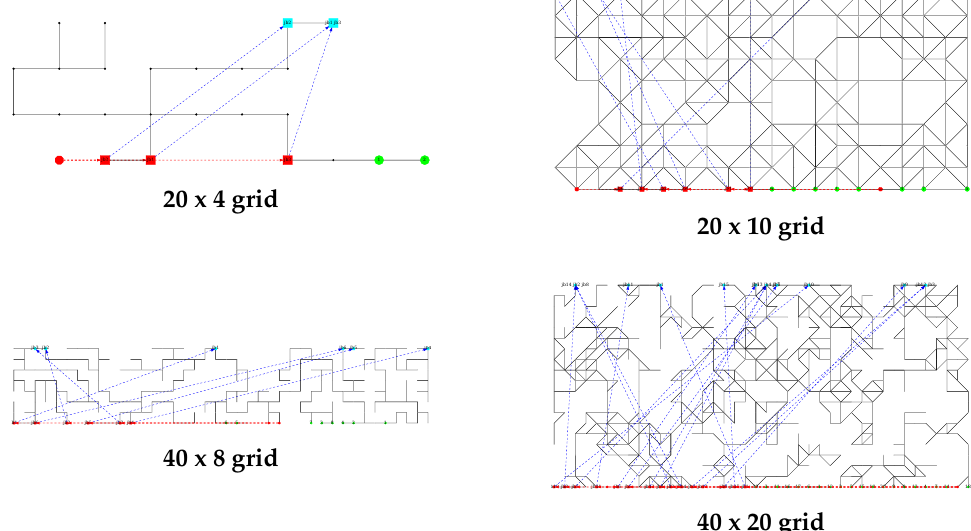
Figure 5. Example synthesized warehouse graphs. Circular green vertices indicate robot home locations. Square red vertices indicate full pallet pickup locations with a dotted blue arrow pointing to the corresponding storage location. Octagonal red vertices indicate empty pallet pickup locations with a dotted red arrow pointing to the delivery location for the corresponding empty